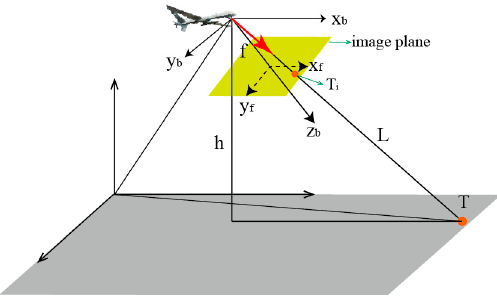
Figure 1. Schematic diagram of single-station localization.